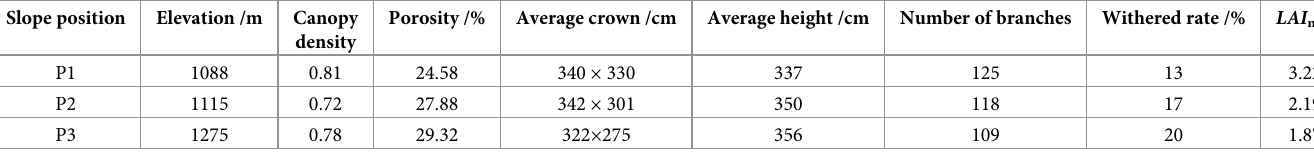
Table 1. Growth status of Salix psammophila on different slopes. Slope